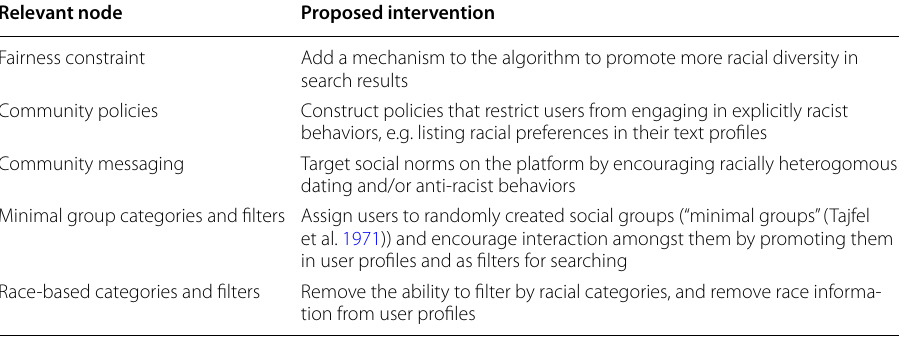
Table 2 A high‑level description (right) of potential interventions proposed by Hutson et al. (2018) to increase inter‑racial relationships on online dating sites, and the nodes in our abstraction hierarchy that are associated with that intervention